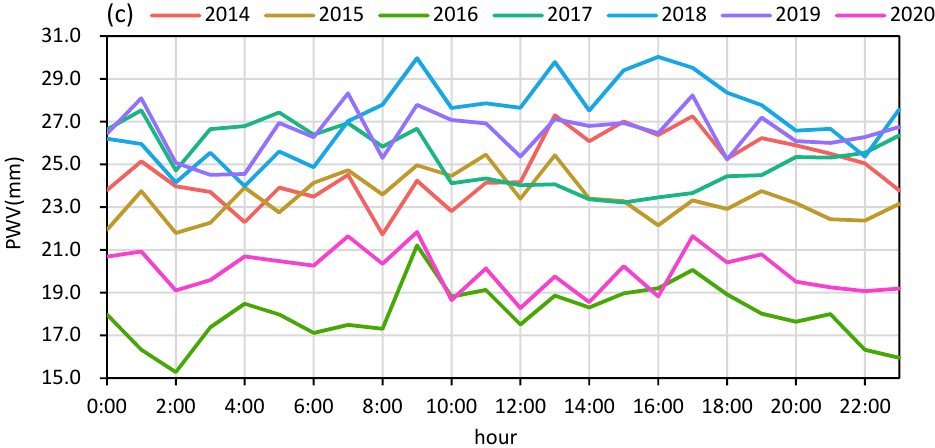
Figure 2. Hourly PWV line graphs of the LPM area from 2014 to 2020. ( a ) Hourly PWV trend of the comprehensive conditions; ( b ) Hourly PWV trend under nonprecipitation conditions; ( c ) Hourly PWV trend under precipitation conditions.